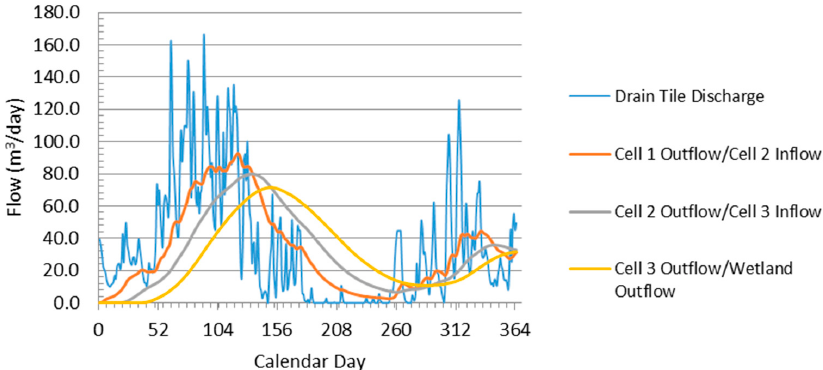
Figure 5. Predicted drainage inflow vs. pool outflow showing from each of the three cells within the treatment wetland.